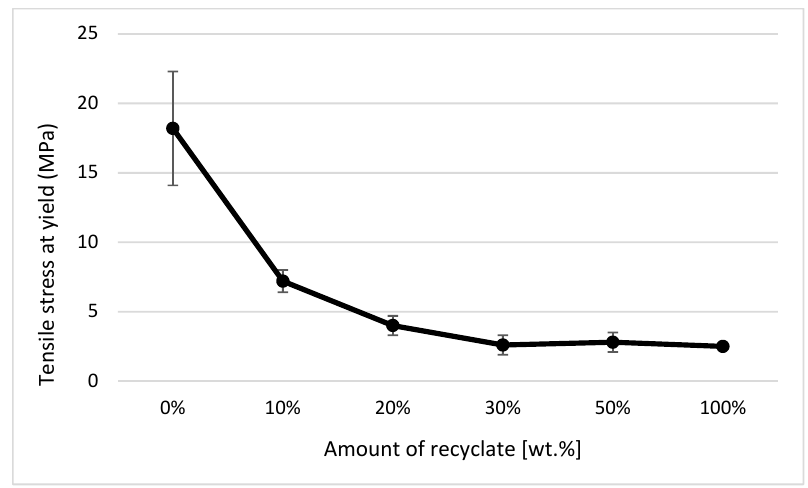
Figure 14. Dependence of stress at yield strength (strength limit) on the proportion of weight of the recycled material after exposure of samples to elevated temperature.